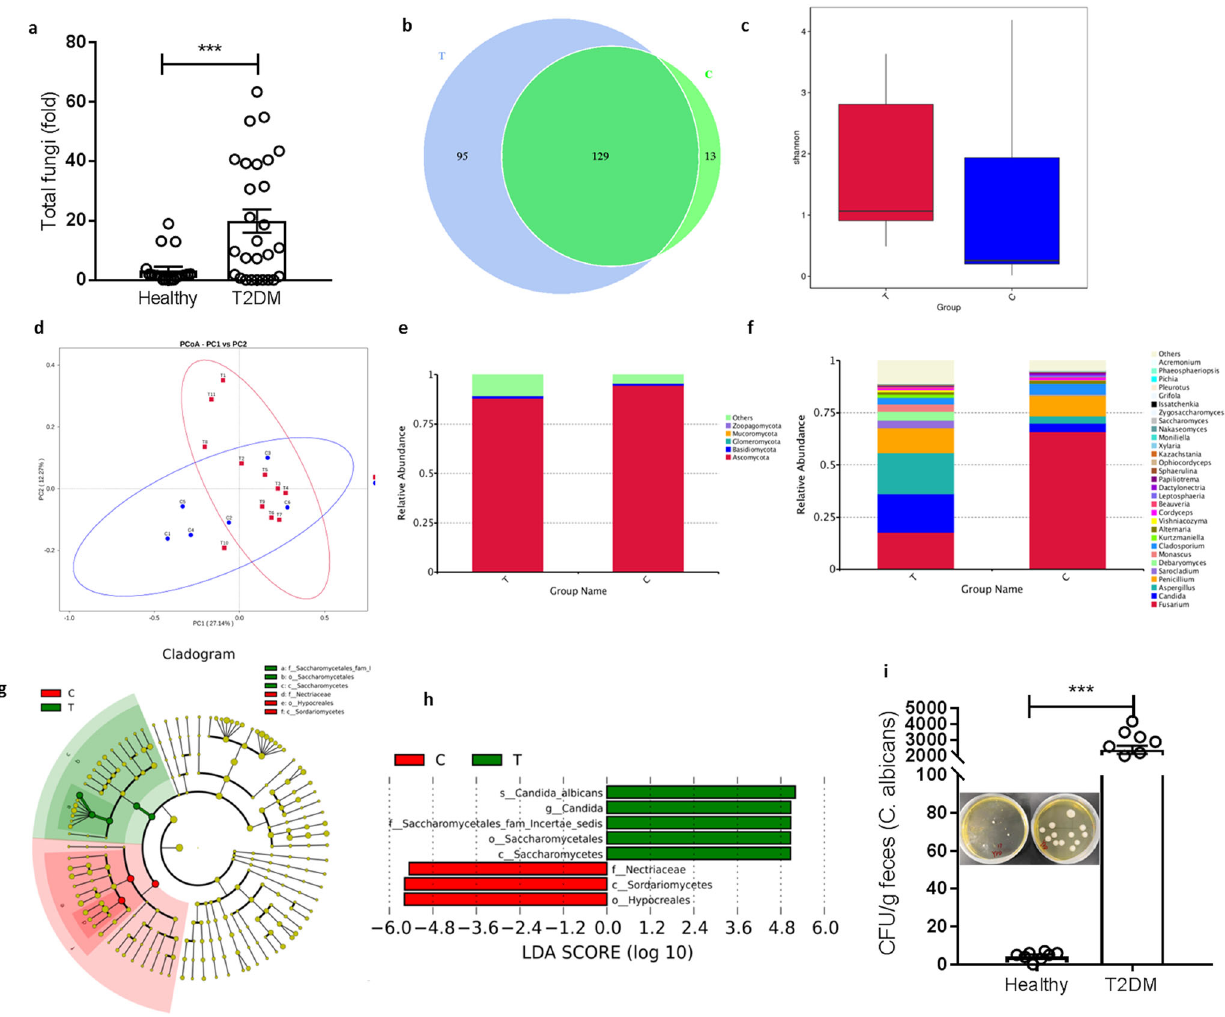
Fig. 2 Gut mycobiome (fungal community) alternations in T2D patients. a Total fungi in feces were assessed by qPCR (healthy group: n = 20, T2DM group: n = 27; *** p < 0.001 vs healthy group), b Venn diagram based on genera, c Shannon index, d Unweighted uniFrac-based principal coordinates analysis, Change in fungi at the phylum ( e ) and genus f levels, g Cladogram generated from LEfSe analysis showing the relationship between taxon, h Linear discriminant analysis (LDA) scores derived from LEfSe analysis, i CFUs of C. albicans in fecal samples (healthy group: n = 8 persons, T2DM group: n = 12 persons; *** p < 0.001 vs healthy group). T: T2DM patients, C: healthy